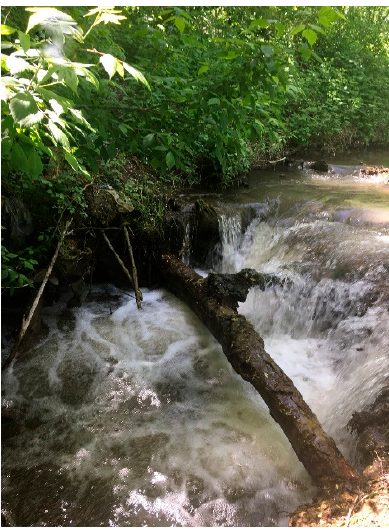
Figure 9. Laslea River refuge habitat.